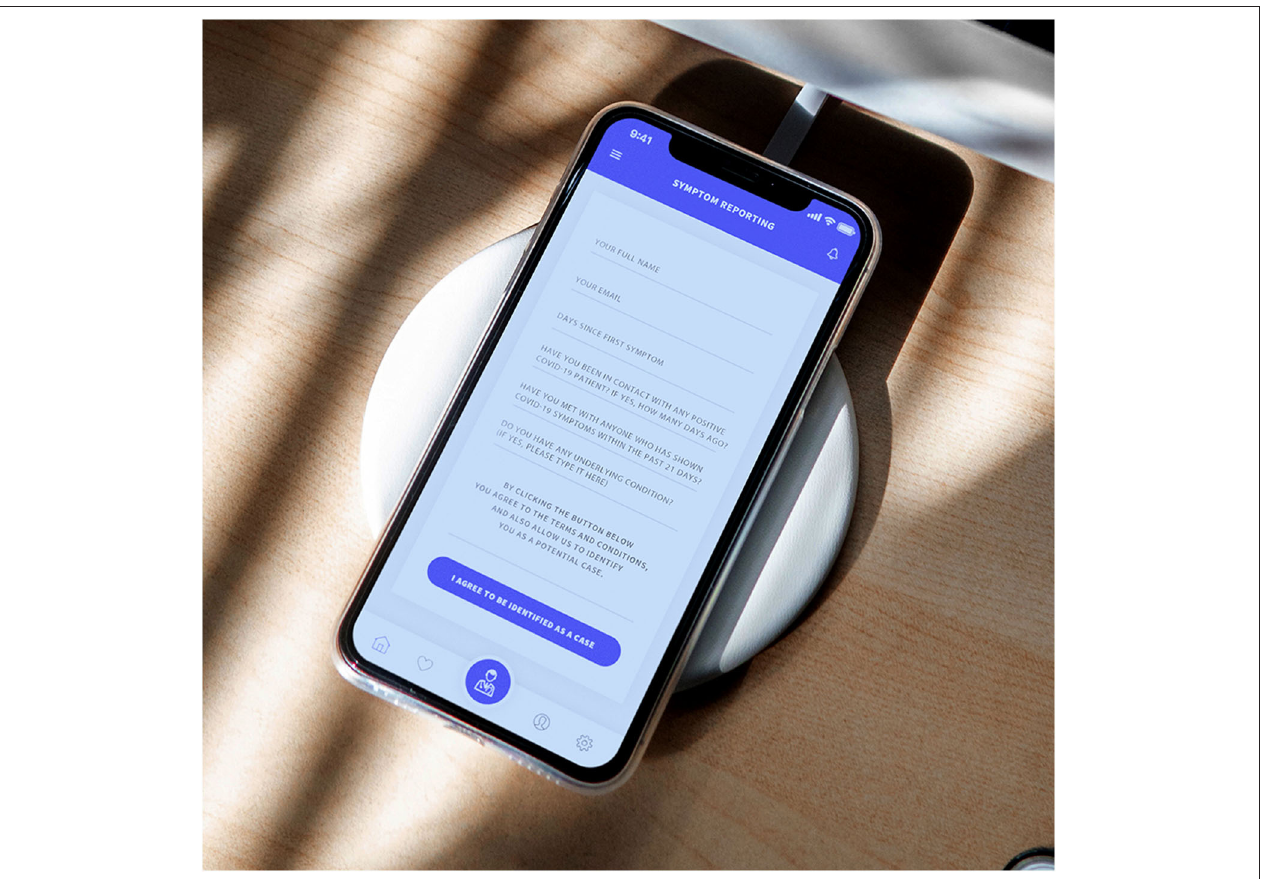
FIGURE 11 | The encrypted form with details to analyze, including the questions required to define a